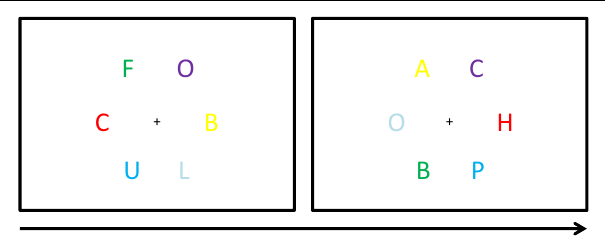
FIGURE 6 | Visual search task. Two exemplary trials. The two target letters of interest (i.e., H and U) appeared more often in a specific associated color. The other letters appeared in each color equally often. Adopted from Kusnir and Thut (2012).